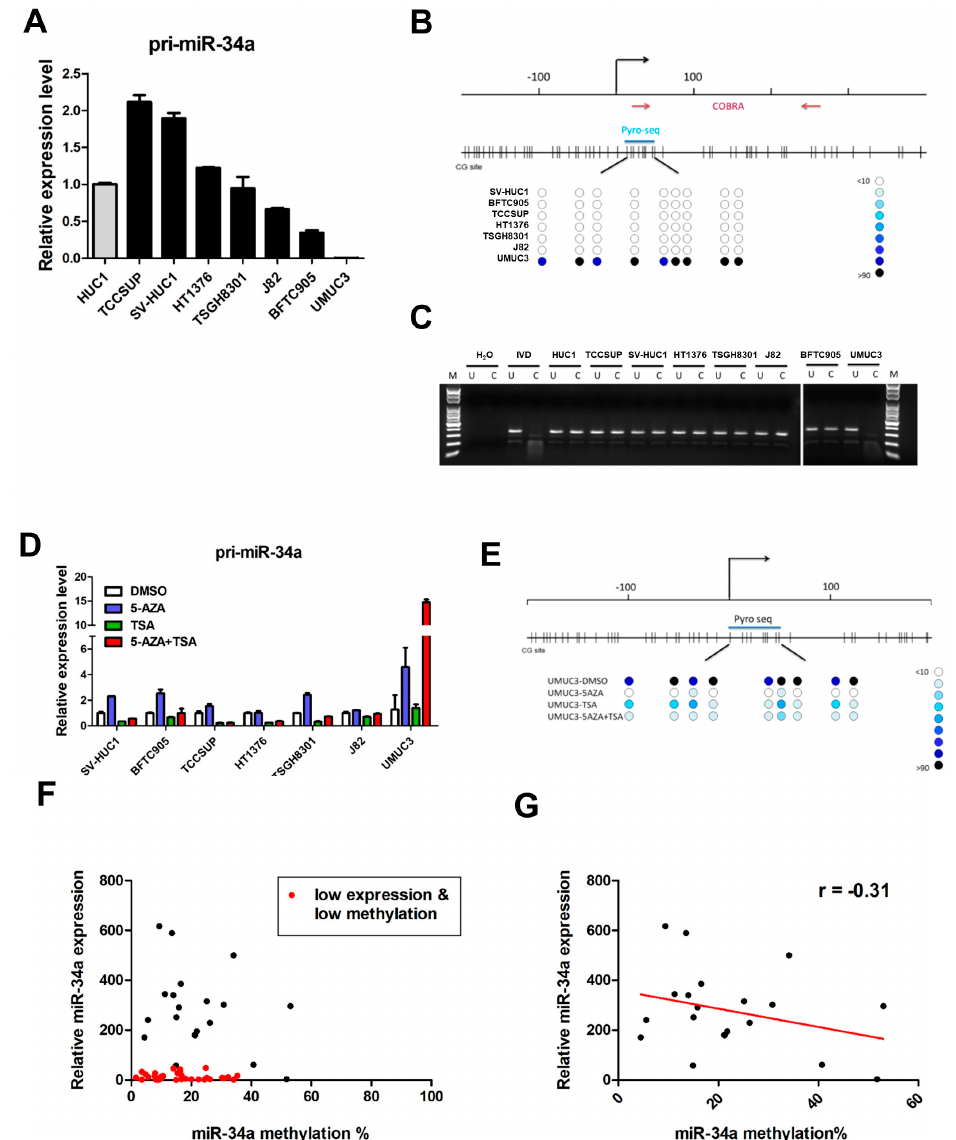
Figure 1. miR-34a is epigenetically silenced by promoter DNA methylation in UMUC3 cell lines, and a subset of urothelial carcinoma (UC) patient samples. ( A ) Expression of pri- miR-34a in normal HUC1 bladder cells and various UC cell lines, relative to GAPDH, as an internal control. Methylation analysis of the miR-34a promoter in various UC cell lines, using ( B ) bisulphite pyrosequencing and ( C ) COBRA assay. The upper panel in ( B ) presents the genomic structure of the miR-34a promoter, with the corresponding locations of all CpG sites from − 200 to + 400. The lower panel in ( B ) illustrates DNA methylation at each CpG site (circle) of various cells, where the intensity of the blue color indicates the degree of methylation. The CpG sites interrogated by bisulphite prosequencing are also indicated. In the COBRA assays in ( C ), bisulphite-modified DNA was amplified via PCR and digested using Bst UI. U, undigested control; C, digested using Bst UI; M, DNA ladder marker; IVD , in vitro methylated DNA. ( D ) Expression of pri -miR-34a in UC cell lines, following epigenetic treatment. UC cell lines treated with 5-aza-2’-deoxycytidine (5aza) and / or trichostatin A (TSA) were examined for pri -miR-34a expression, using qRT-PCR. Error bars represent standard deviations calculated from duplicates. ( E ) Bisulphite pyrosequencing analysis of the miR-34a promoter in UMUC3 cells treated with various epigenetic drugs, as in ( D ). ( F ) Scatter plot showing expression and promoter methylation of miR-34a in 55 urothelial carcinoma patient samples, showing a distinct group of patient samples (red dots) with both low expression and low promoter methylation of miR-34a . Analysis of the other patient samples (methylated) showed an inverse correlation (r = − 0.31) between expression and methylation of miR-34a , as shown in ( G ).